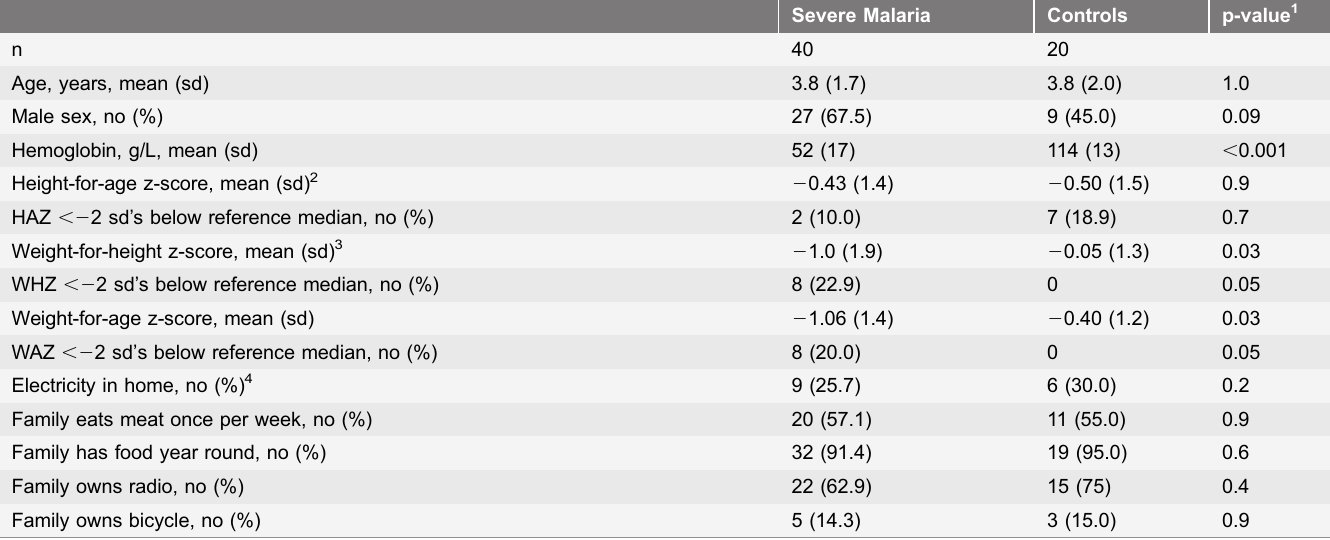
Table 1. Clinical and socioeconomic characteristics of study children.